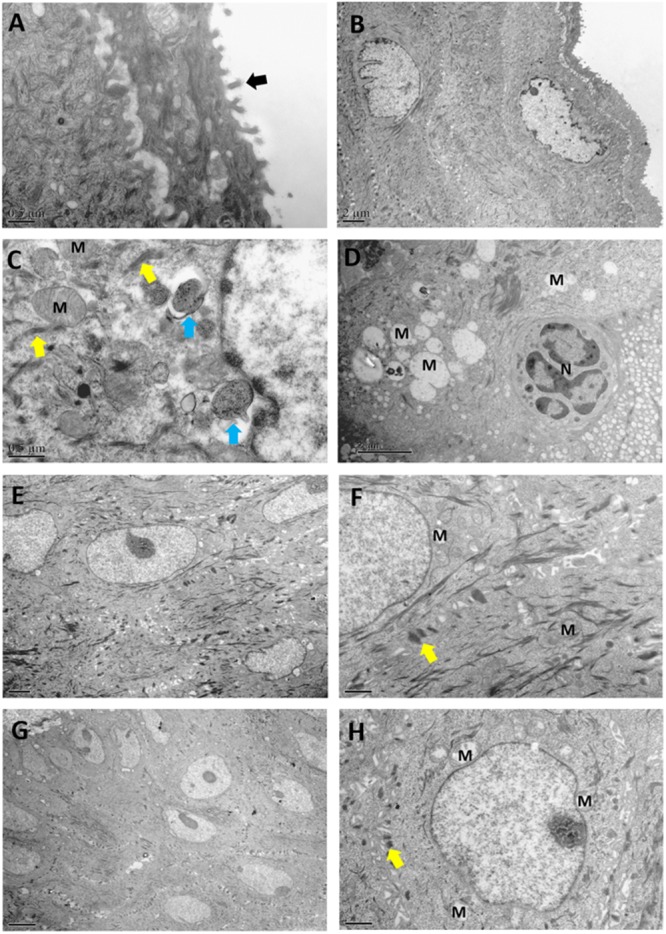
Ultrastructural changes in the vaginal mucosa of rats observed by transmission electron microscopy. Control, uninfected (A,B); Model, infected with 1 × 108 CFU/ml C. albicans
(C,D); L. crispatus treated, infected and treated with L. crispatus 3.0 × 108 CFU for 7 days (E,F); L. delbrueckii treated, infected and treated with L. delbrueckii 3.0 × 108 CFU for 7 days (G,H). Rats in the Control group show normal vaginal morphology with a non-keratinized stratified squamous epithelium and intact microvilli (black arrow) extended by vaginal epithelial cells. Yeast cells (blue arrow) invading the superficial layers of the vaginal mucosa, with injured desmosome-like junctions (yellow arrow) and swollen mitochondria (M) after infection with 1 × 108 CFU/ml C. albicans.